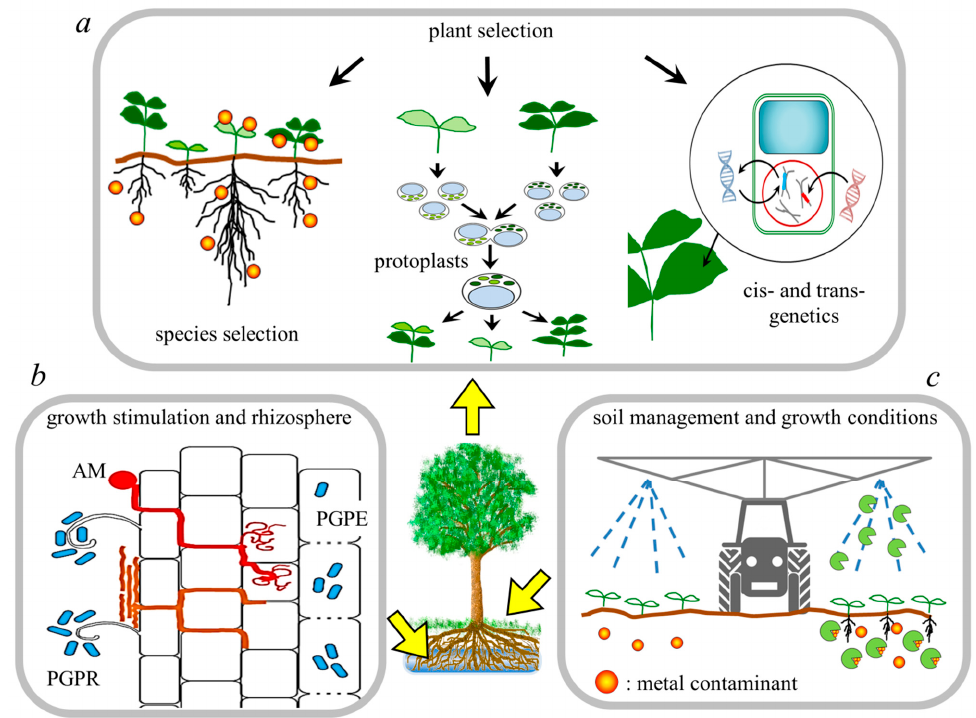
Figure 2. Main aspects of human intervention to enhance phytoremediation. Steps in which human activity can operate are, ( a ) the selection, through varietal choice, classical breeding (e.g., somatic hybridization), or transgenic approach, of the most useful plant species to be applied; ( b ) the enhancement of rhizosphere interconnections between plant growth promoting rhizo- and endophytic bacteria (PGPR and PGPE, respectively, blue dots), and mycorrhizal fungi (drawn in red -arbuscular mychorrizae, AM - and orange), exploiting ex-novo inoculum or the native microflora; ( c ) the management of the polluted site, in terms of both soil conditions and growth techniques, which can change metal availability, plant growth, and remediation e ff